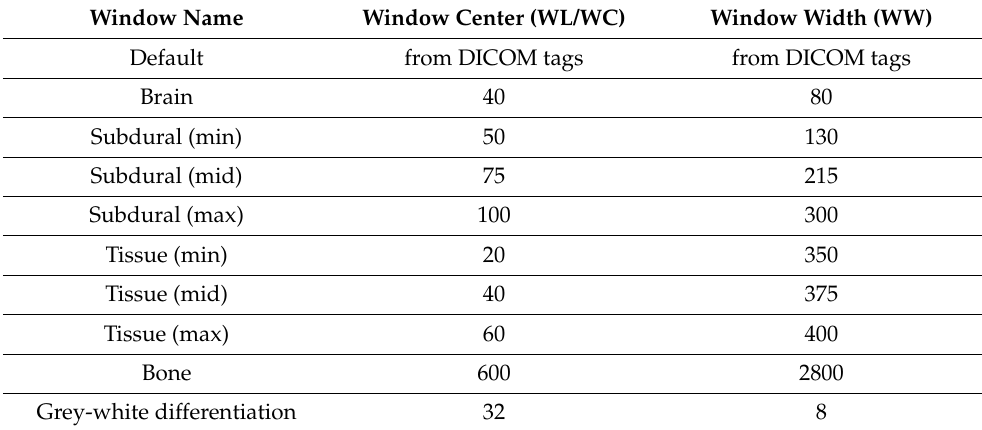
Table 4. Different window